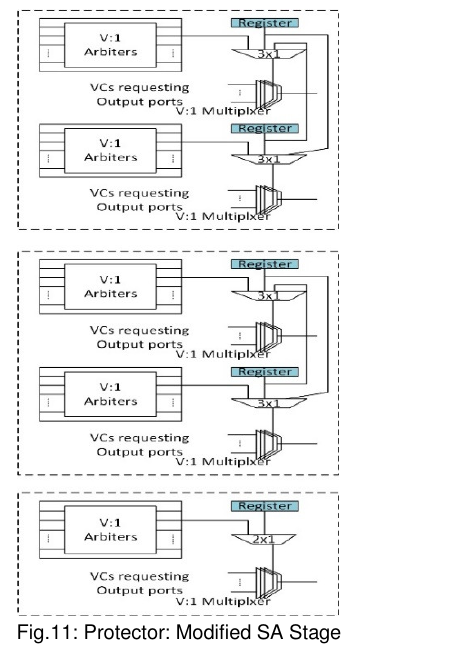
Fig.11: Protector: Modified SA Stage